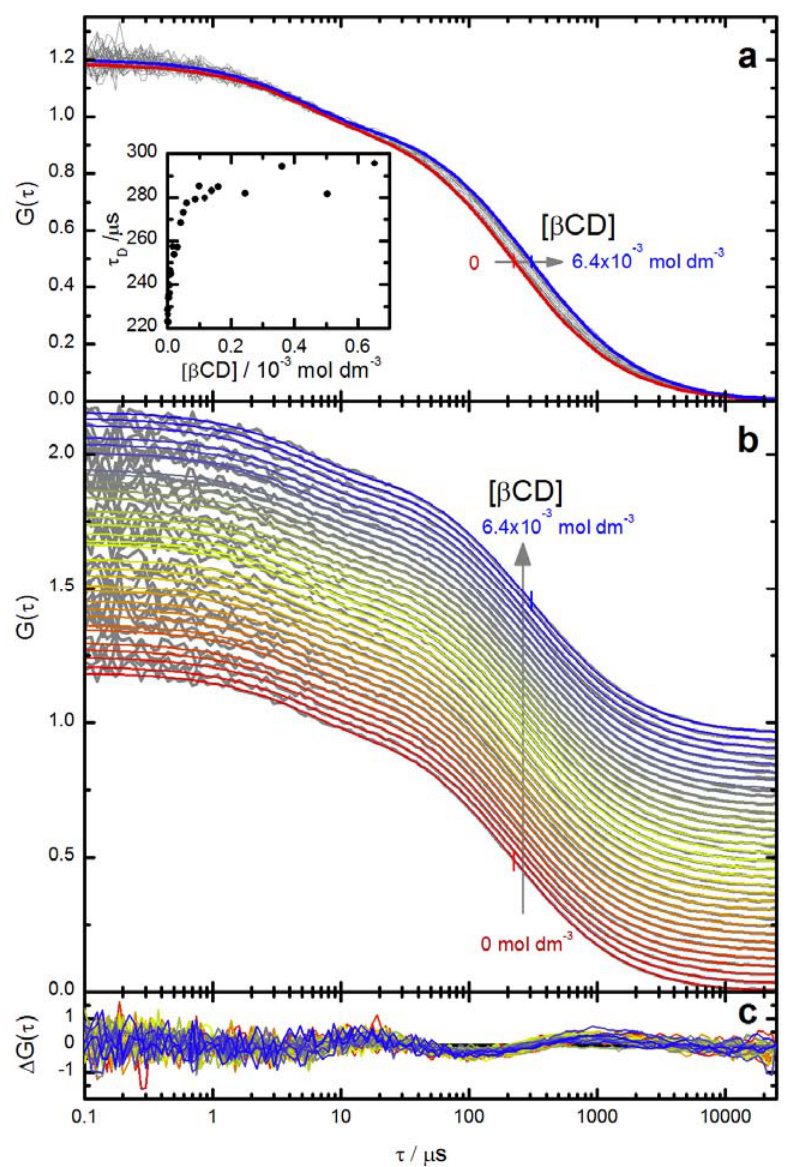
Figure 4. Fluorescence intensity correlation curves G ( τ ) of Ada-A488 in the presence of increasing concentrations of β CD ([ β CD] = 0 mol dm -3 to 6.4 × 10 -3 mol dm -3 ) in aqueous solution. ([Ada-A488] ≈ 10 -9 mol dm -3 ). Panel a: normalized experimental correlation curves at increasing β CD concentration (grey curves) and two representative curves from the global fit of Equations. (9) and (10) at [ β CD] = 0 mol dm -3 (red curve) and [ β CD] = 6.4 × 10 -3 mol dm -3 (blue curve) to the correlation curves. The intermediate fit curves are not shown for clarity.Small vertical bars indicate the diffusion time obtained from the fit. Inset: mean diffusion times τ as function of β CD concentration determined D from individual fits of the Equation (9) to the correlation curves. The highest concentrations are not shown. See also Figure 5. Panel b: stacked representation of the same correlation curves as in panel a. Panel c: weighted residuals from the global fit (vertical scale is